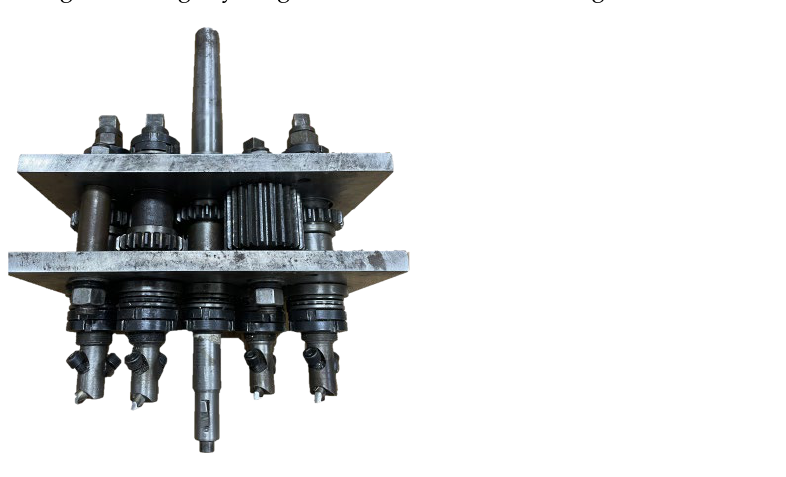
( b ) Figure 6. ( a ) transplanting trajectory with decreasing corner; ( b ) transplanting trajectory with in- creasing corner. As the gearbox contains five shaft holes that need to be processed, the ordinary bor- ing process needs to be clamped repeatedly in the process of boring. Many clamps are not only laborious, but also need to be repositioned after each processing of a shaft hole, which greatly improves the error and reject rate. For initial casting of a gearbox blank of possible problems such as pore size accuracy and surface roughness and the gearbox of batch pro- cessing, we designed a five hole processing tool as shown in Figure 7. Clamping can real- ize five shaft hole processing, reduce processing datum transformation, improve the pro- cessing precision, and efficiency of gearbox. The processing tool mainly includes five power shafts, limit shafts, power commutation shafts, etc. The five power shafts are in- stalled and positioned according to the relative position of each shaft hole in the gearbox,